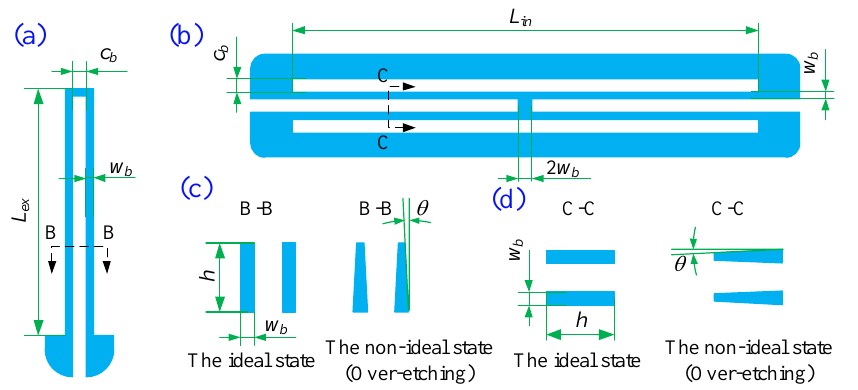
Figure 4. The structure of the support beams and the inclination angles, ( a ) the enlargement of the external elastic beam, ( b ) the enlargement of the internal elastic beam, ( c ) the enlargement of the section view B, and ( d ) the enlargement of the section view C, where L ex = 800 µ m, L in = 1660 µ m, c b = 30 µ m, and w b = 15 µ m.